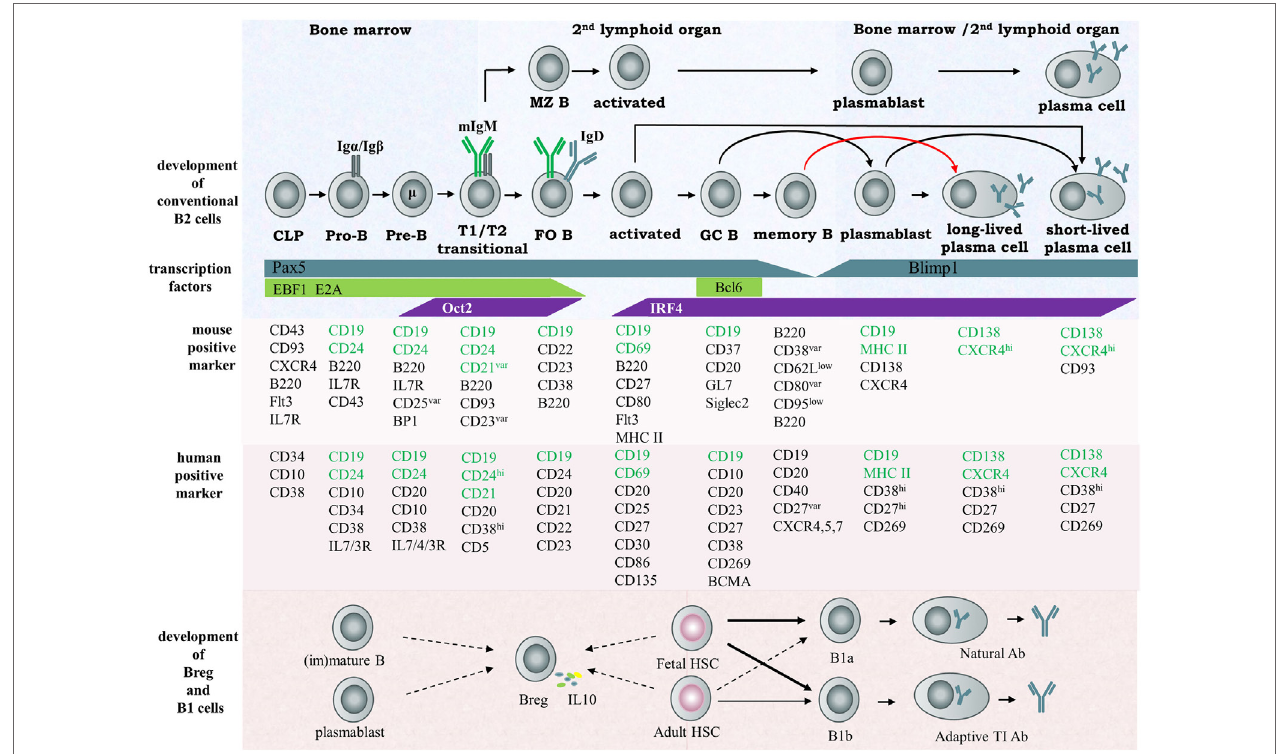
FiGURe 1 | Scheme of B cell development and subsets in humans and mice. According to their individualized origin, surface marker, anatomic localization and functional property, B lymphocytes can be divided into several subsets, including B-1a cell, 1b cell, Breg cell, and B2 cell, the latter considered the conventional B cell. In the early stage, B cells differentiate from hematopoietic precursors into pro-B, pre-B within the bone marrow, then migrate to the spleen and progress through the transitional T1 and T2 stages. These immature cells then differentiate into FO or MZ naïve B cells depending on their special B cell receptor. MZ B cells rapidly develop into plasma cells secreting IgM during the early stage of pathogen infection and function as the first defense line against blood-borne pathogens. FO B cells enter germinal centers and undergo class switch recombination (CSR), somatic hypermuation (SHM), and affinity maturation and terminally differentiate into memory B cells or plasma cells. The important transcription factors and surface markers in human or murine involved in conventional B cell development are shown. The origin of regulatory B cells and B1 cells is still not identified. Here, the solid arrows represent known developmental routes while the dashed arrows represent possible development directions. Abbreviation: CLP, common lymphoid